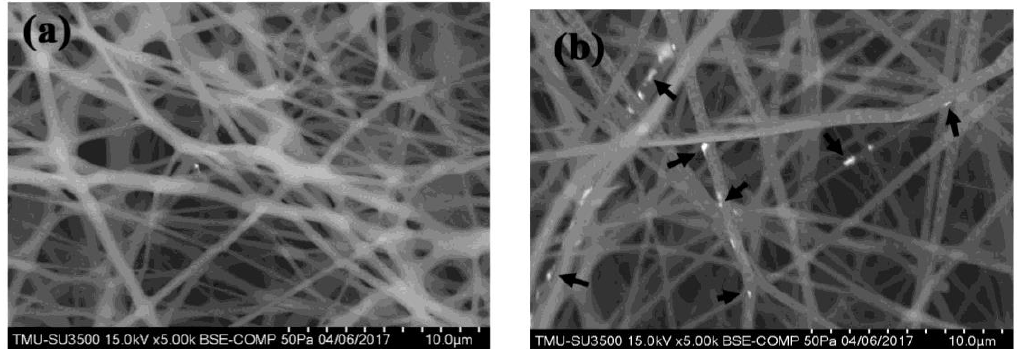
Figure 2. SEM microstructures of electrospun PLLA nanofibers incorporating Fe 3 O 4 nanoparticles. ( a ) Neat PLLA nanofibers; and ( b ) Fe 3 O 4 nanoparticles (black arrows) integrated within PLLA nanofibers.